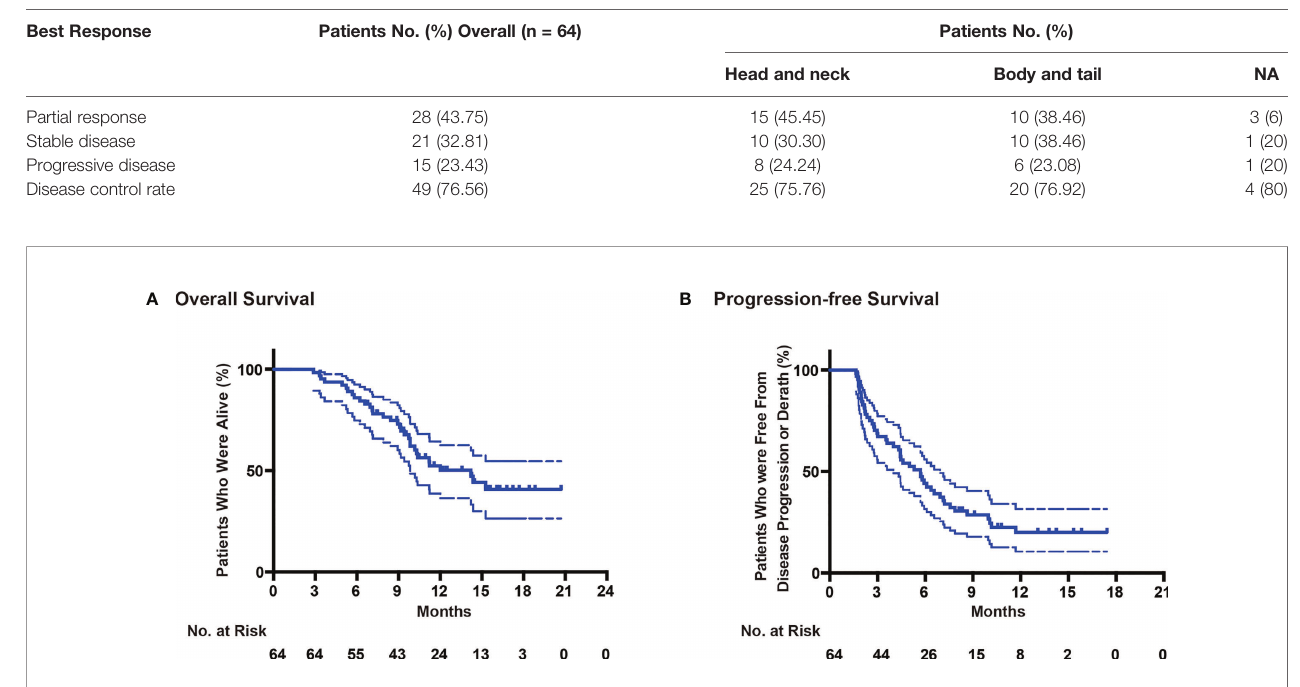
FIGURE 3 | Survival analysis. (A) Overall survival, (B) Progression-free survival.